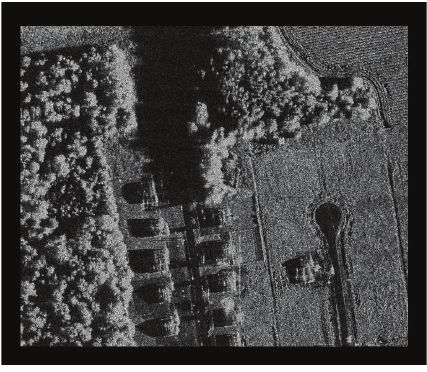
Figure 13. The imaging result of distributed target based on proposed